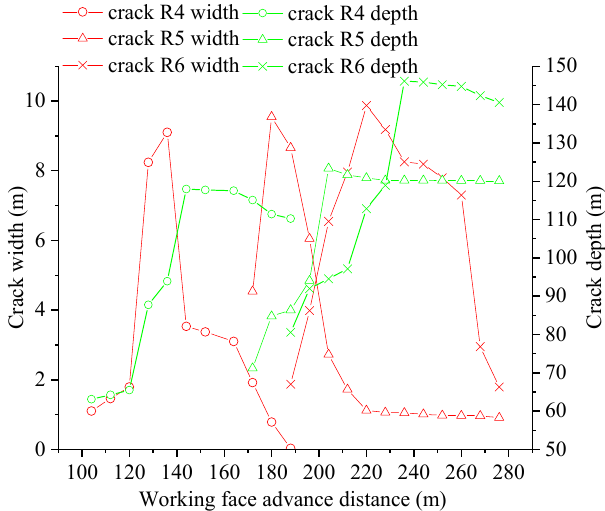
Figure 15. Variations of width and depth of fractures R4–6 with advancing working face.